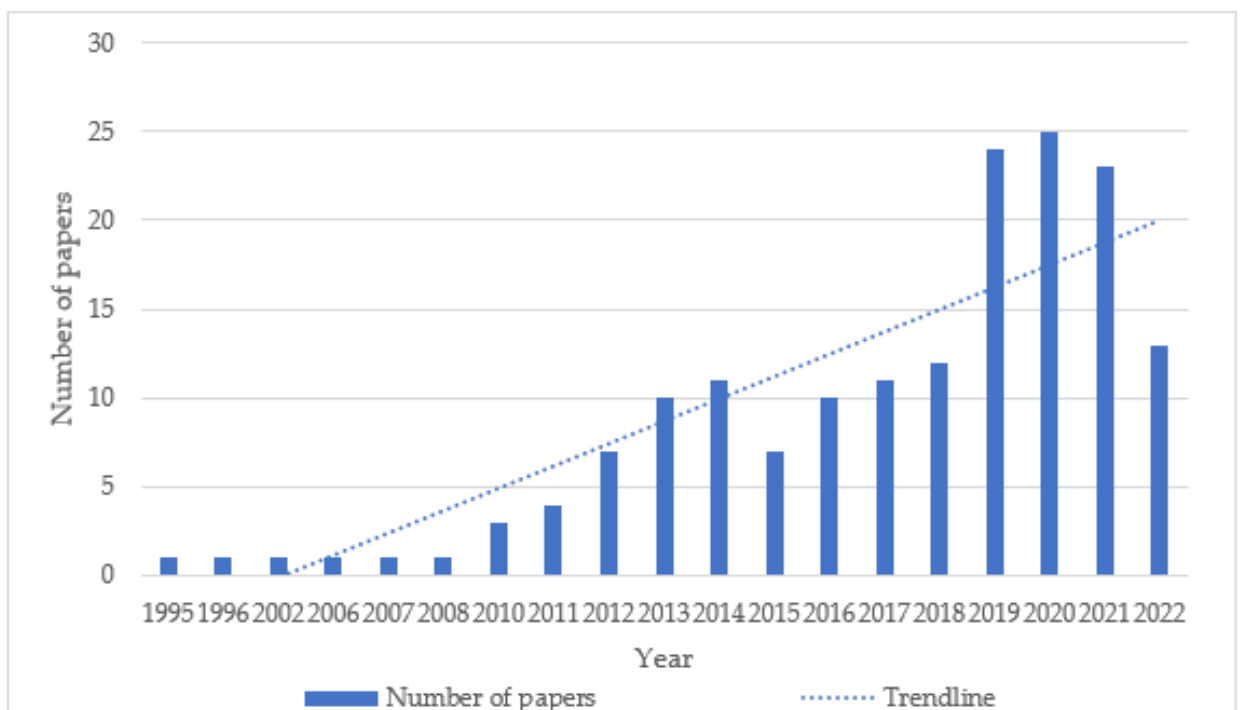
Figure 2. The number of papers published per year.